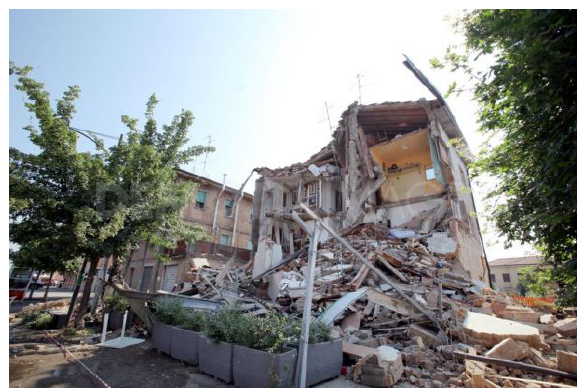
Figure 15. Global collapse of masonry building.